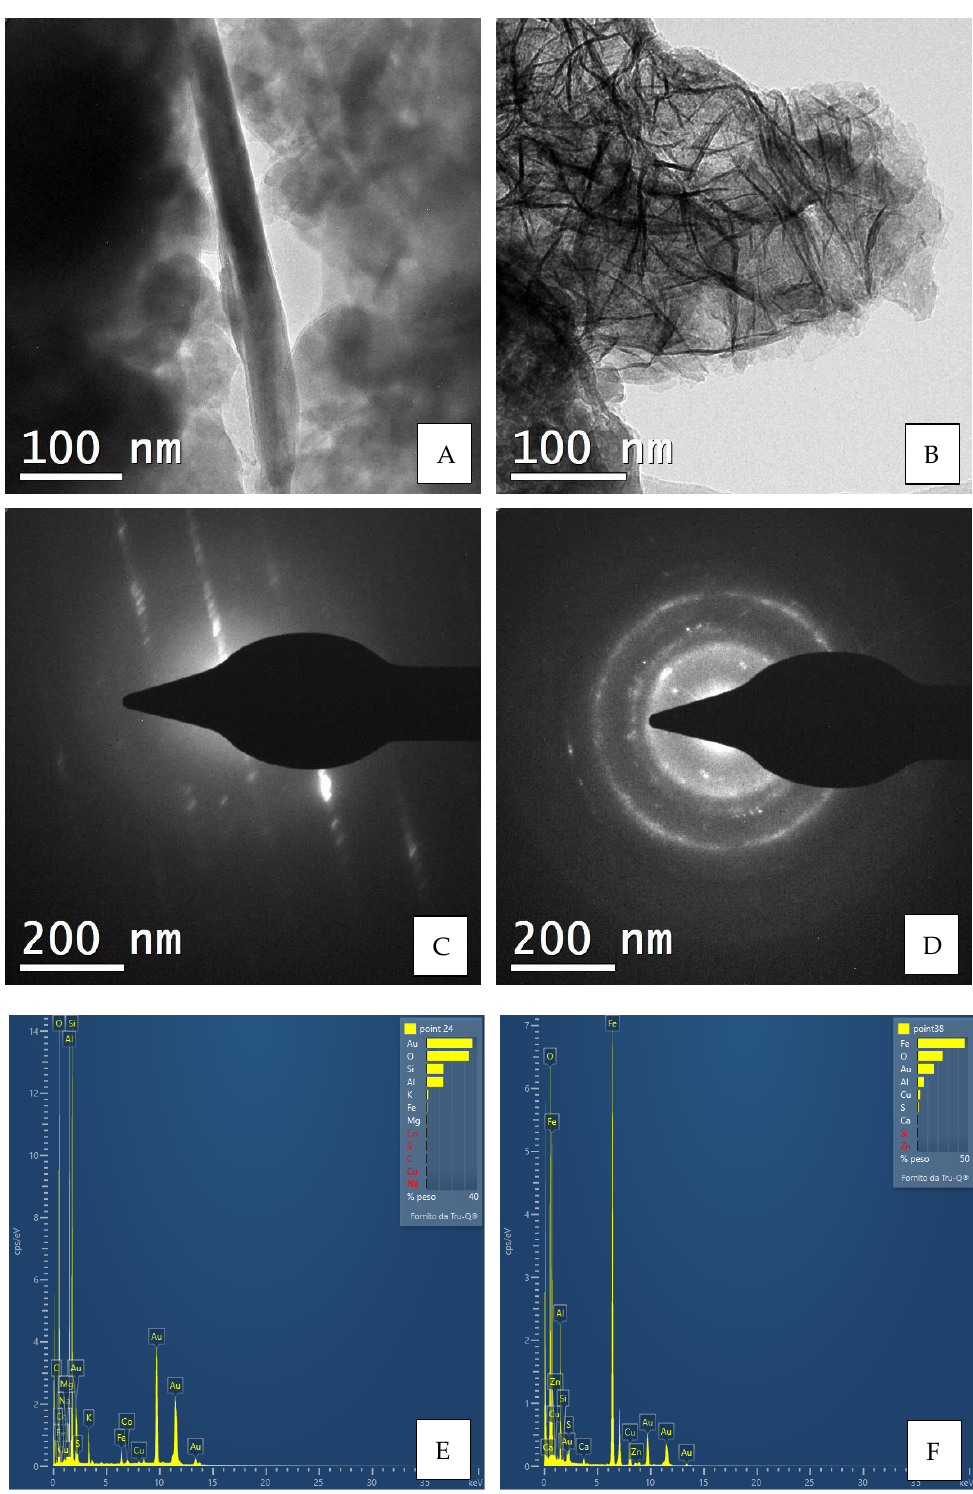
Figure 9. Precipitated phases from FA3-S sample, analyzed by TEM. Nano-crystal aggregates ( A ) and subhedral crystal (B ) with relative diffraction patterns ( C , D ). Their EDS analyses show an Al- silicate (hydrated?) ( E ) and a probable Mg-carbonate ( F ).